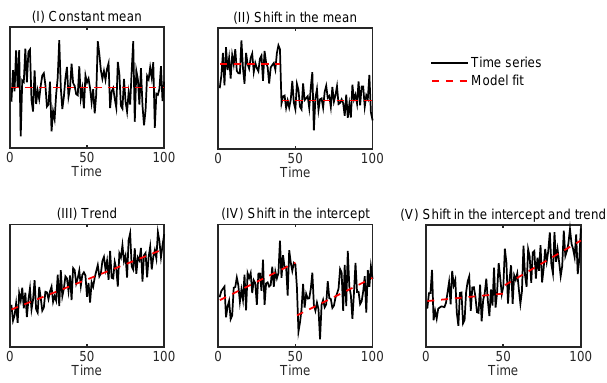
Figure 1. Five types of statistical models that were fitted to the data. The solid lines are synthetic time series drawn from a model with (I) a constant mean, (II) shift in the mean, (III) trend, (IV) shift in the intercept of the trend (the trend is the same before and after the shift) and (V) shift in both the intercept and trend. The constant mean (I) is the null model for a shift in the mean (II) when testing for significance. Similarly, the trend model (III) is the null model to test the shift significance when the model selected is either a shift in the intercept (IV) or a shift in both the intercept and trend (V) . The corresponding models are further described in Table 2. Figure adapted from Beaulieu et al.